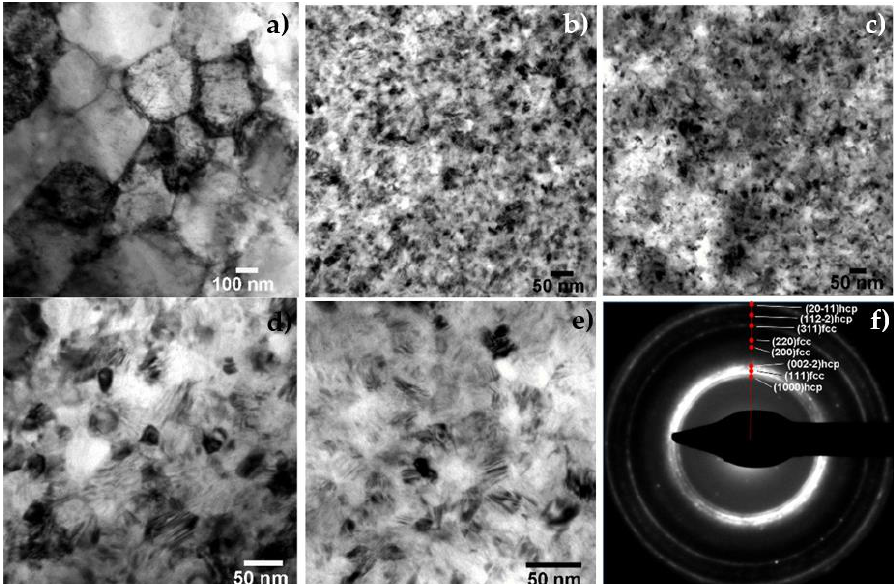
Figure 3. Representative TEM micrographs of ultrafine-grained cobalt obtained by ( a ) BM + SPS, ( b ) BM + SPS + ECAP-B C /1, ( c ) BM + SPS + ECAP-B C /2, ( d ) BM + SPS + ECAP-B C /3, and ( e ) BM + SPS + ECAP-B C /4. ( f ) SAEDP rings (aperture size 80 nm) refer to the BM + SPS + ECAP-B C /1 condition.